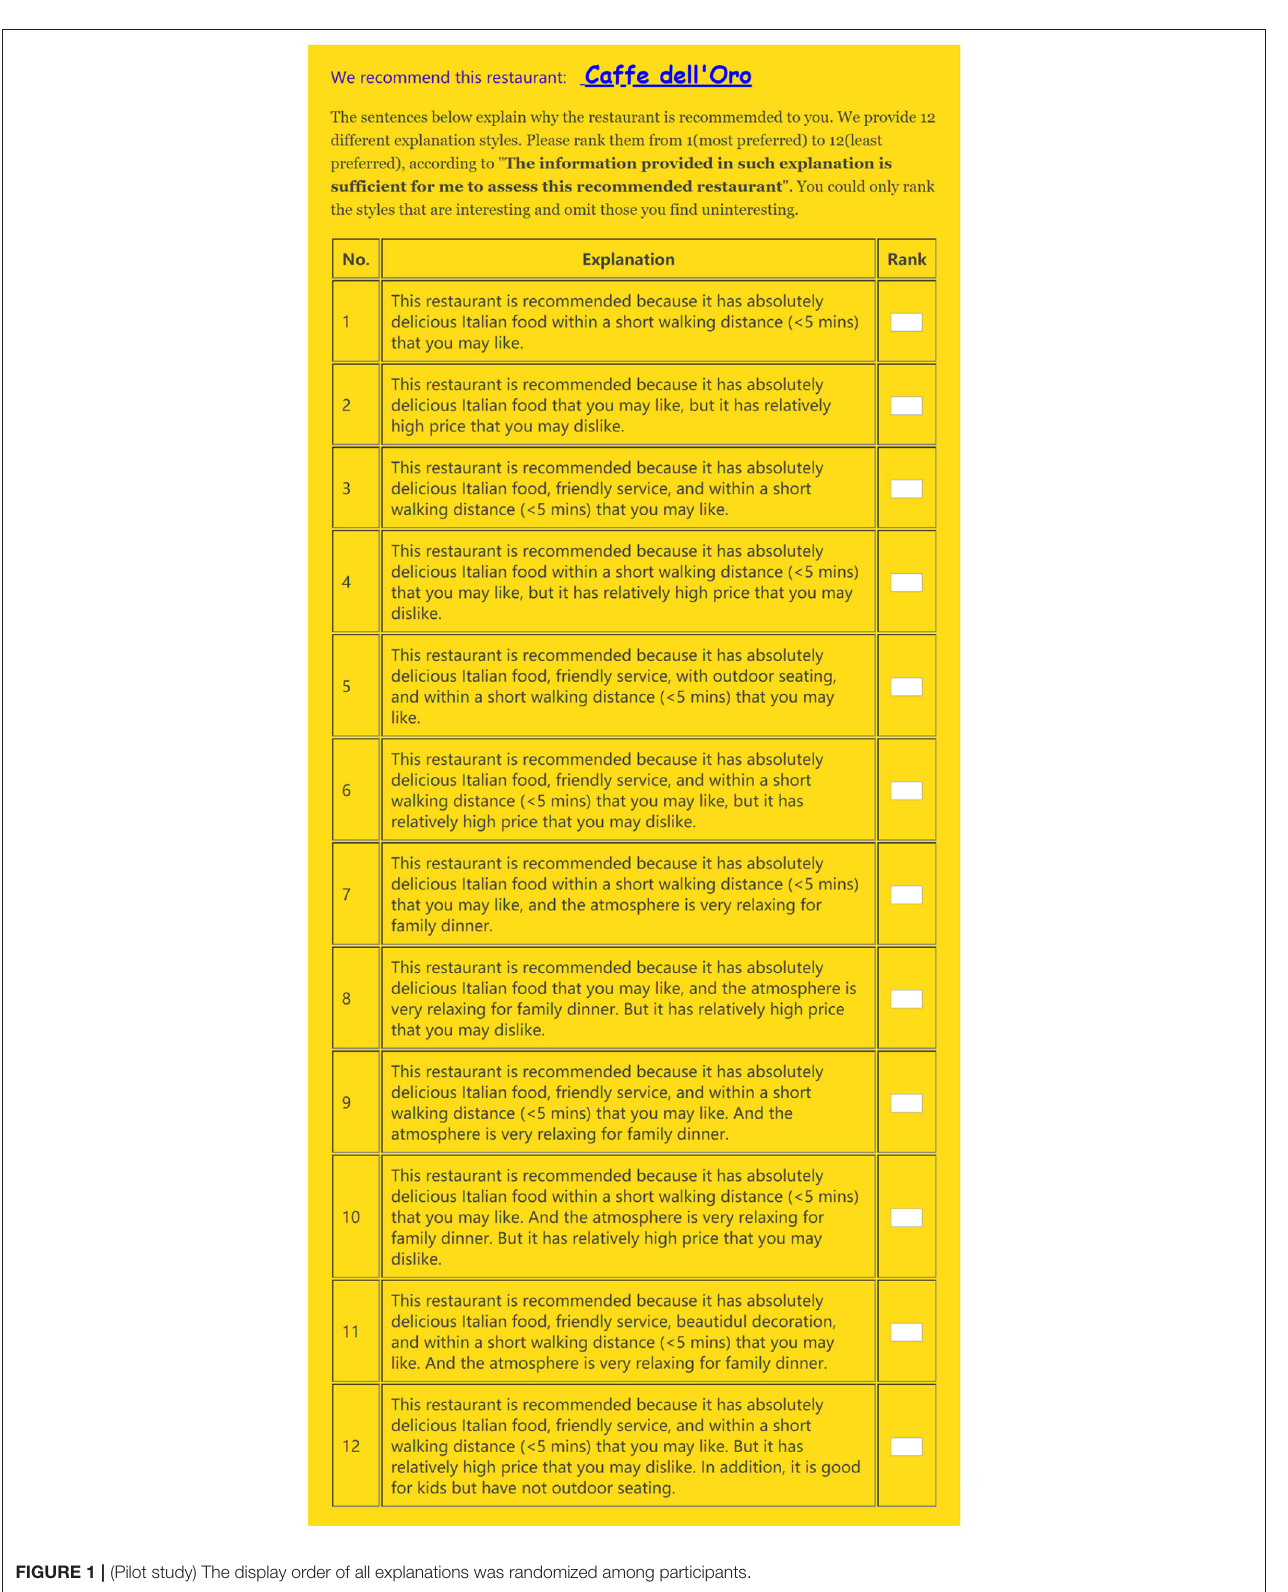
Frontiers in Big Data |